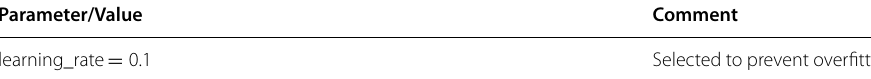
Table 4 Supervised ranking classifier LightGBM initialization options